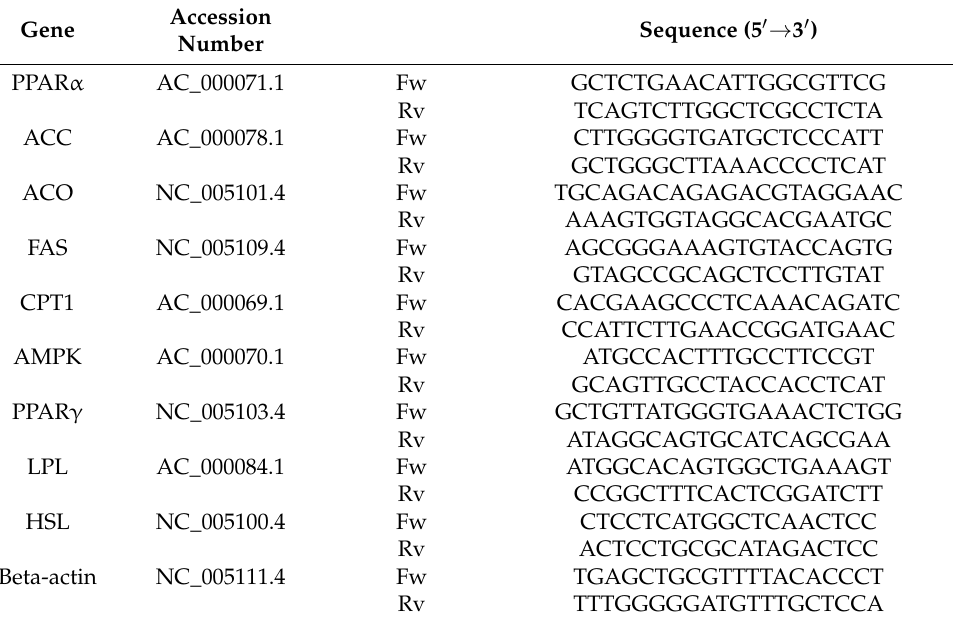
Table 3. List of primers used to amplify mRNA by quantitative real-time